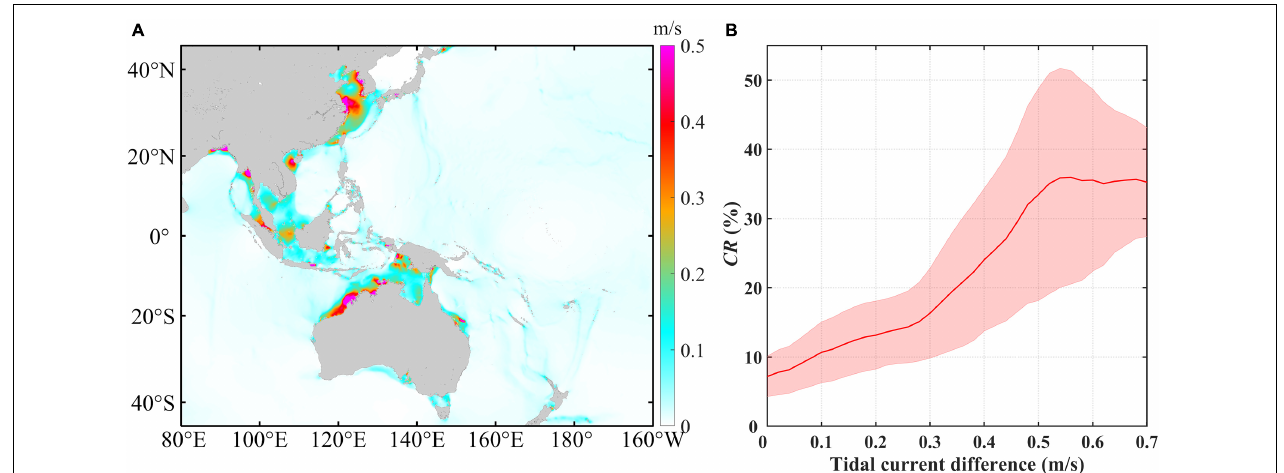
FIGURE 8 | (A) Spatial distribution of the annual averaged spring-neap tidal current difference maximum. (B) Annual averaged spring-neap tidal current difference maximum vs. Chl- a contribution rate ( CR ) induced by the spring-neap tide. The red curve represents the average and the pink shading indicates the error bar derived from the standard deviation.